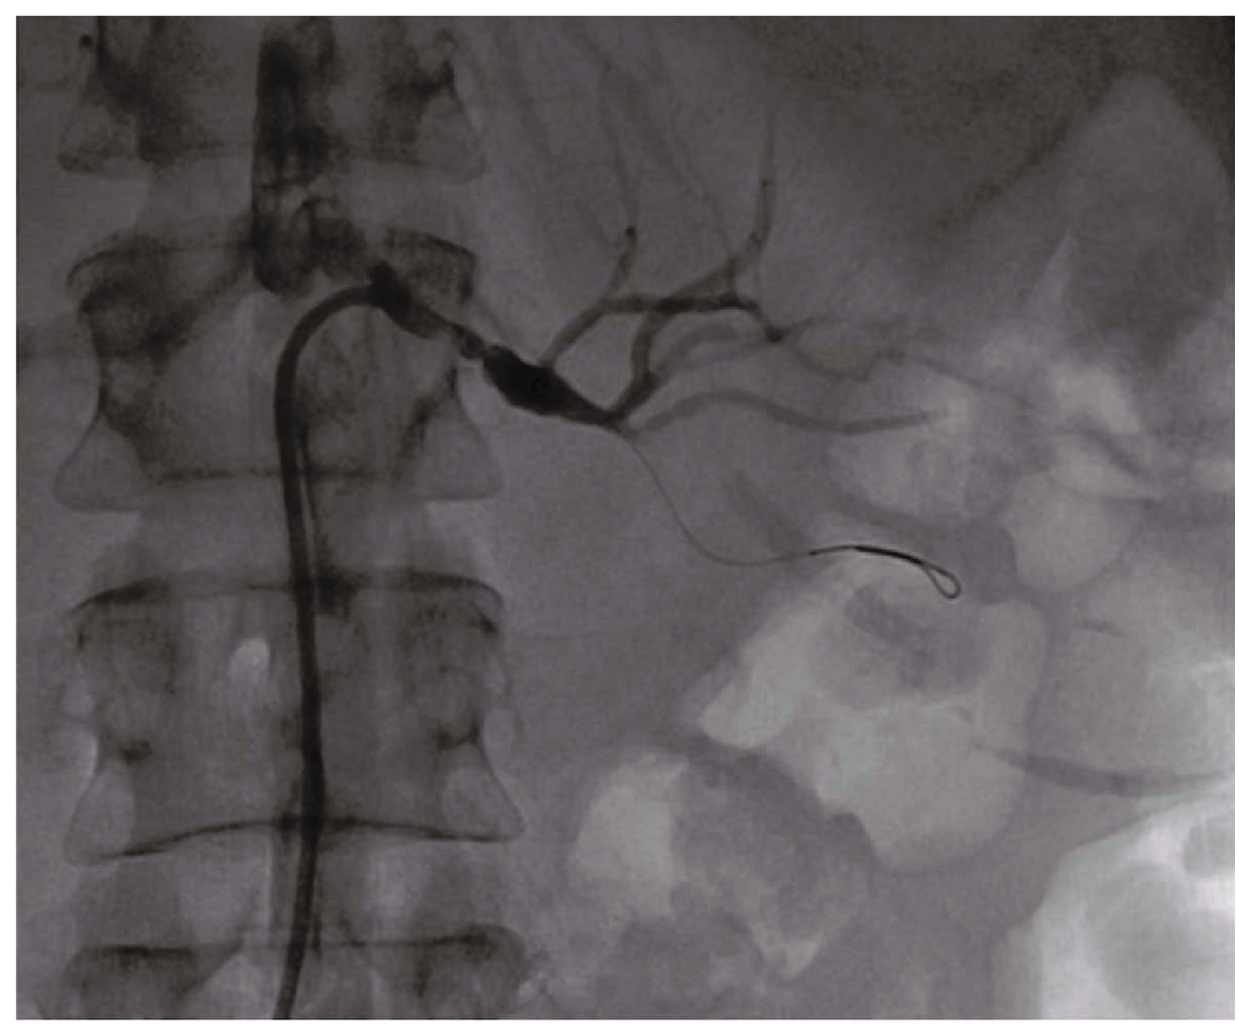
Figure 5: After aspiration thrombectomy, underlying irregular angiographic appearance looks like a plaque rupture at the ostial left renal artery suggesting in situ thrombosis rather than